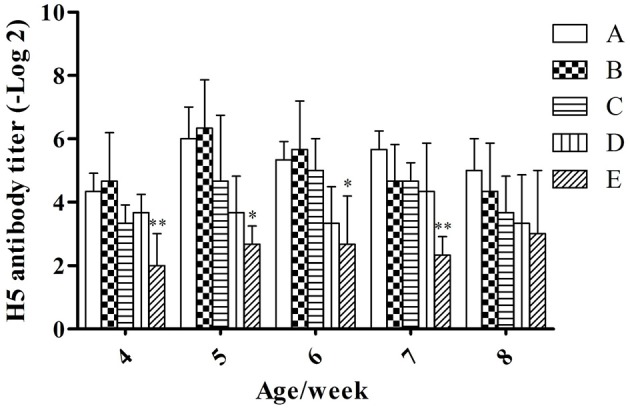
H5 AIV antibody titer under different hygienic conditions (n = 60). Note: The comparison was between treatment groups (B–E) and control group (A) at the same age/week, *P < 0.05 and **P < 0.01. The same as below. *Means that the difference between treatment groups (B–E) and control group (A) was significant.